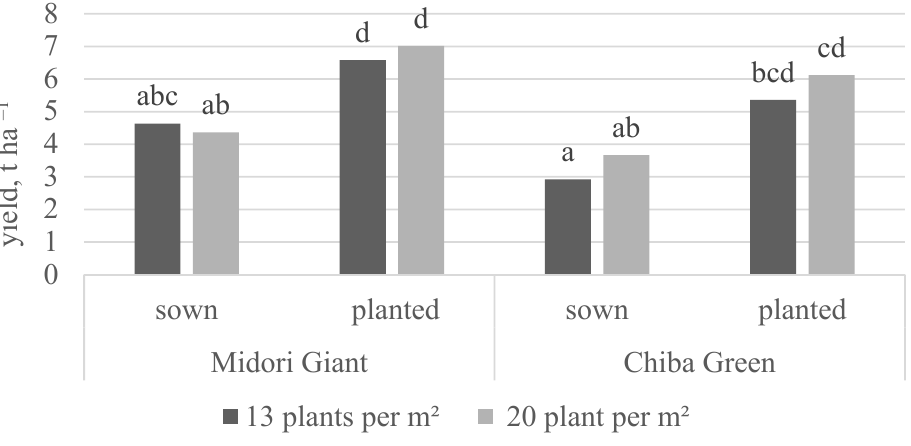
Figure 5. Vegetable soybean fresh pod yield in 2019, in Latvia. n = 2. Values marked by different